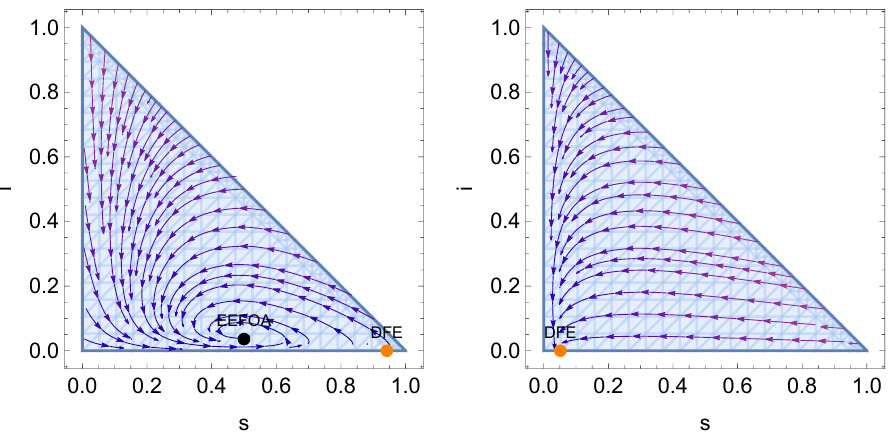
β 2 , two endemic points emerge—see Figure 4d (Theorem 1(2(c)(ii))). The lower endemic point exits the only stable point.